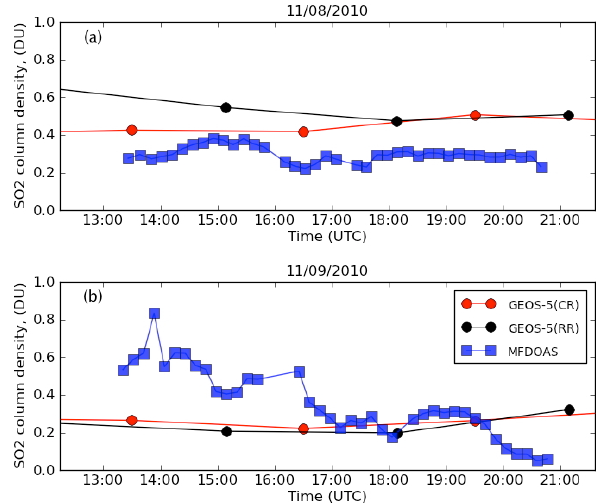
Fig. 11. Daily variations of the SO 2 total column amount on 8 November 2010 (top) and 9 November 2010 (bottom) at the Piney Run Station. Blue squares are MFDOAS measurements, red and black circles are model simulations with the control and revised runs